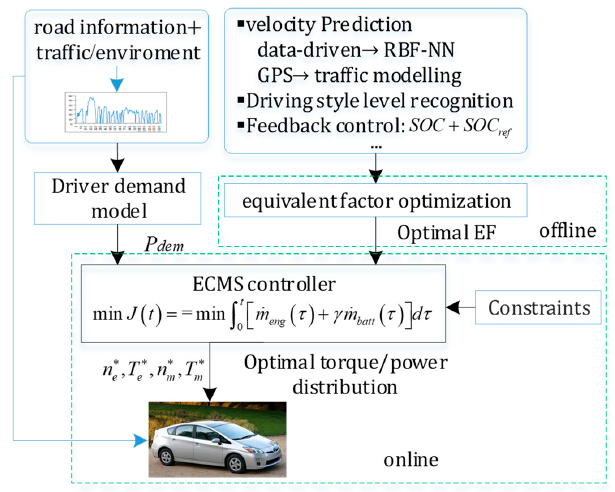
Figure 4. Depiction of the main research areas of ECMS.